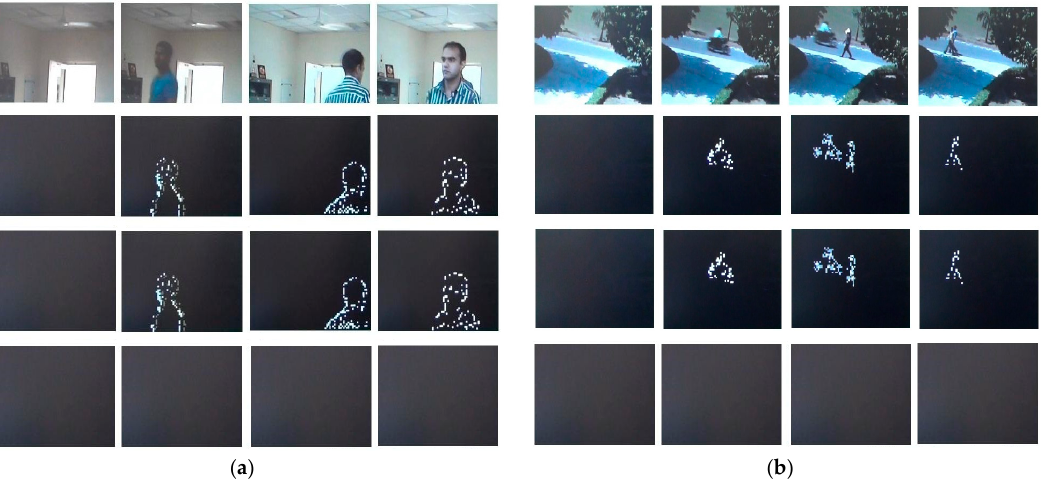
Figure 4. Comparison of results of the proposed memory efficient motion detection algorithm with the original clustering based motion detection scheme for: ( a ) indoor scenario; and ( b ) outdoor scenario.